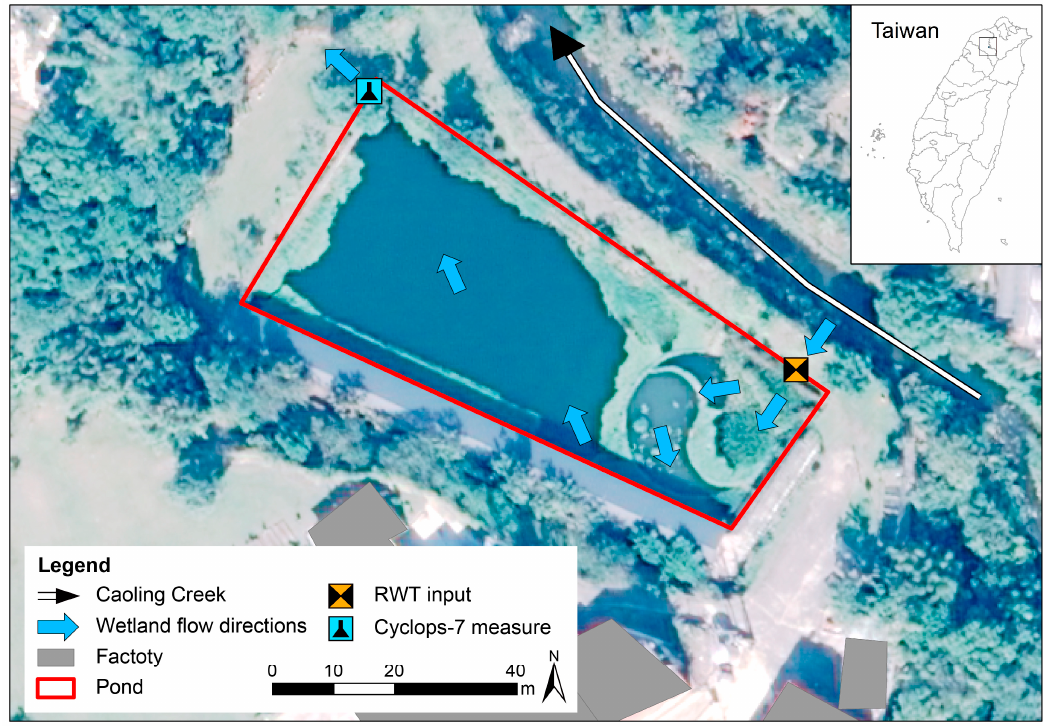
Figure 1. Location of the study area. The blue arrows indicate the flow inlet and outlet, and the schematic shows the main flow direction.